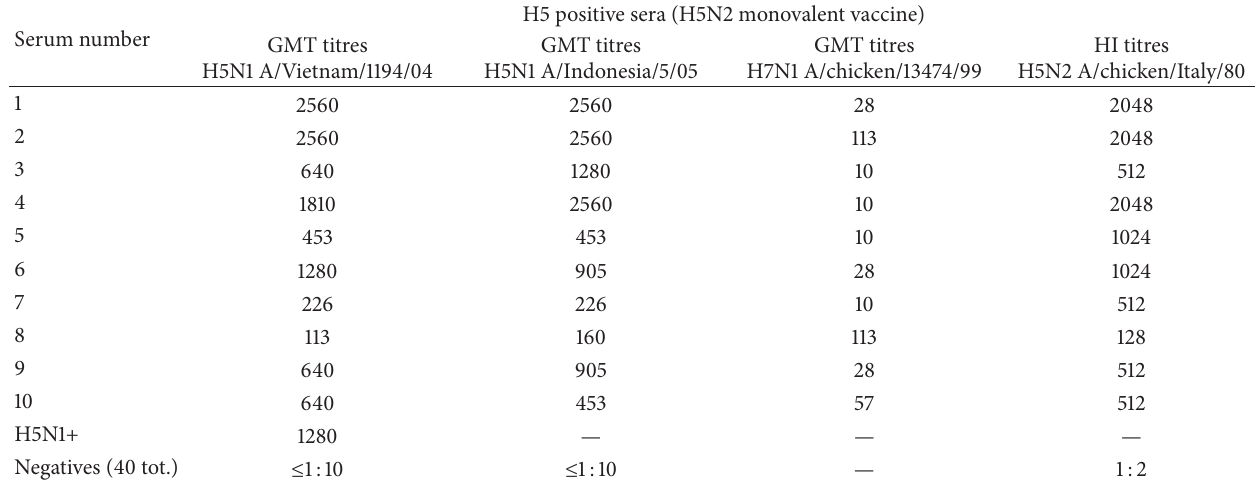
Table 1: Comparison of neutralizing activity of a panel of sera collected from chickens vaccinated with an inactivated H5N2 monovalent vaccine.